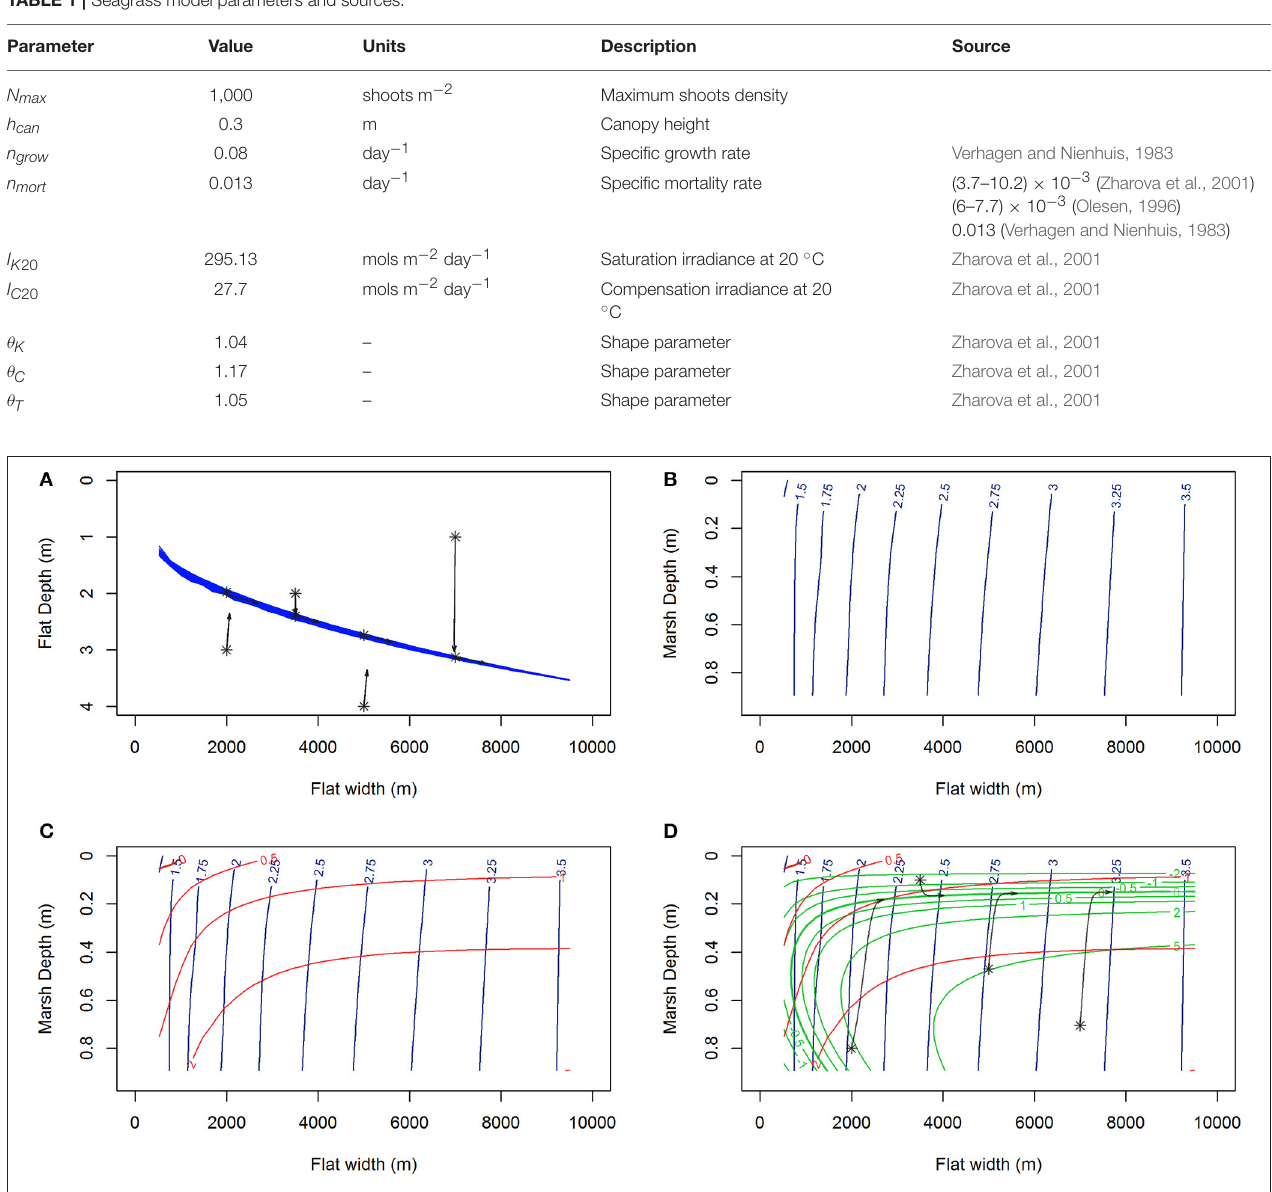
FIGURE 2 | (A) The collection of tidal flat depth nullclines (blue lines) and 1000 year trajectories (black) of the system showing little lateral change until the nullcline depth has been reached for RSLR = 4mm year − 1 , Co = 30 mg/L and constant wind speed, U const = U = 6.87m s − 1 . (B) Those same nullclines, or nullcline plane, now shown as contours of tidal flat depth (m) in the plane of tidal flat width and marsh depth. (C) Contours are added showing curves of constant rate of change (m/year) of tidal flat width (red) along the surface defined by the tidal flat depth nullcline contours (blue). In this case, for almost all flat width and marsh depths, the system would exhibit lateral erosion. Positive and negative values signify lateral erosion and progradation respectively, the thick red line represent where the lateral erosion rate is zero. (D) Addition of the contours of marsh depth rates of change (mm/year, green) along the same tidal flat depth nullcline surface and trajectories of the system initiated on the nullcline surface. Positive and negative values signify vertical accretion and loss respectively, the thick green line represent where the marsh vertical accretion rate is zero. Again as the system is initiated along the tidal flat depth nullcline surface (B), trajectories ( D , black) exhibits lateral erosion and progression to a equilibrium marsh